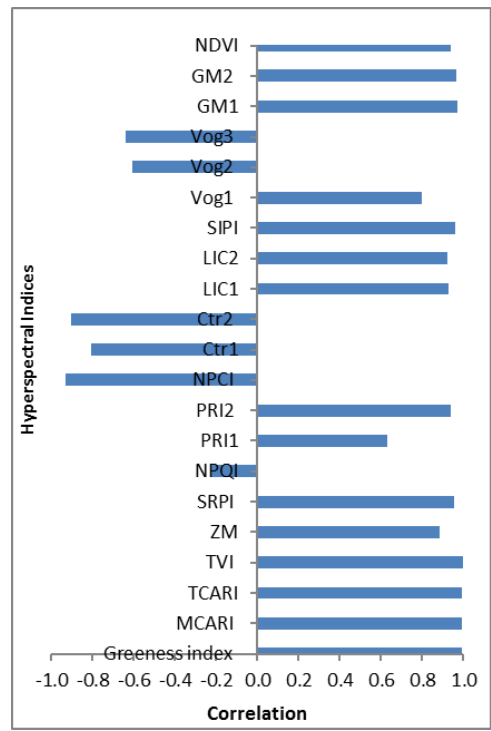
Figure 7 Correlation between chlorophyll content and Hyperspectral indices